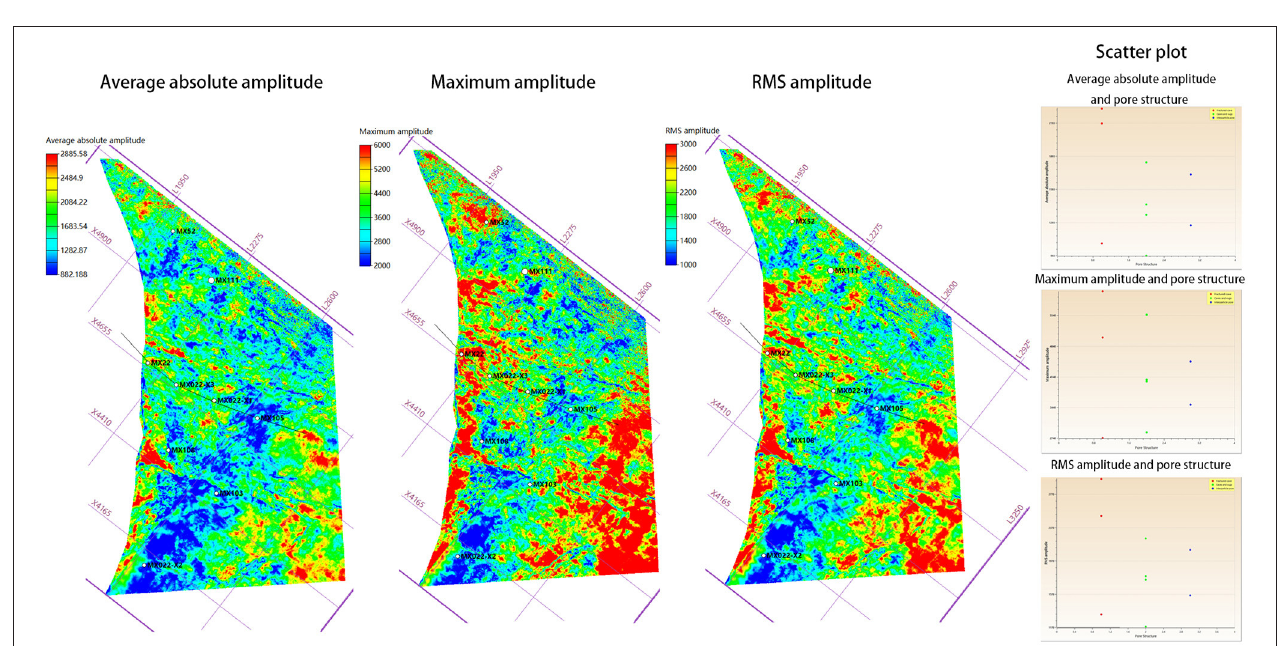
FIGURE 8 | Conventional seismic attribute (average absolute amplitude, RMS amplitude, and maximum amplitude) profiles and their relationship with the pore structures.